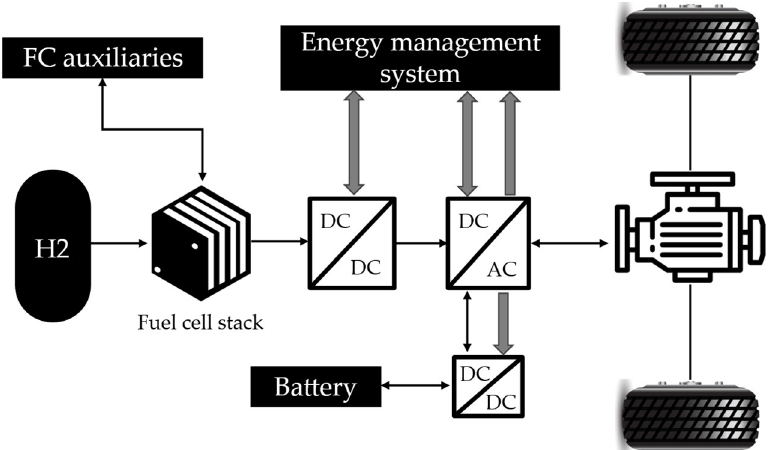
Figure 1. FCHV powertrain